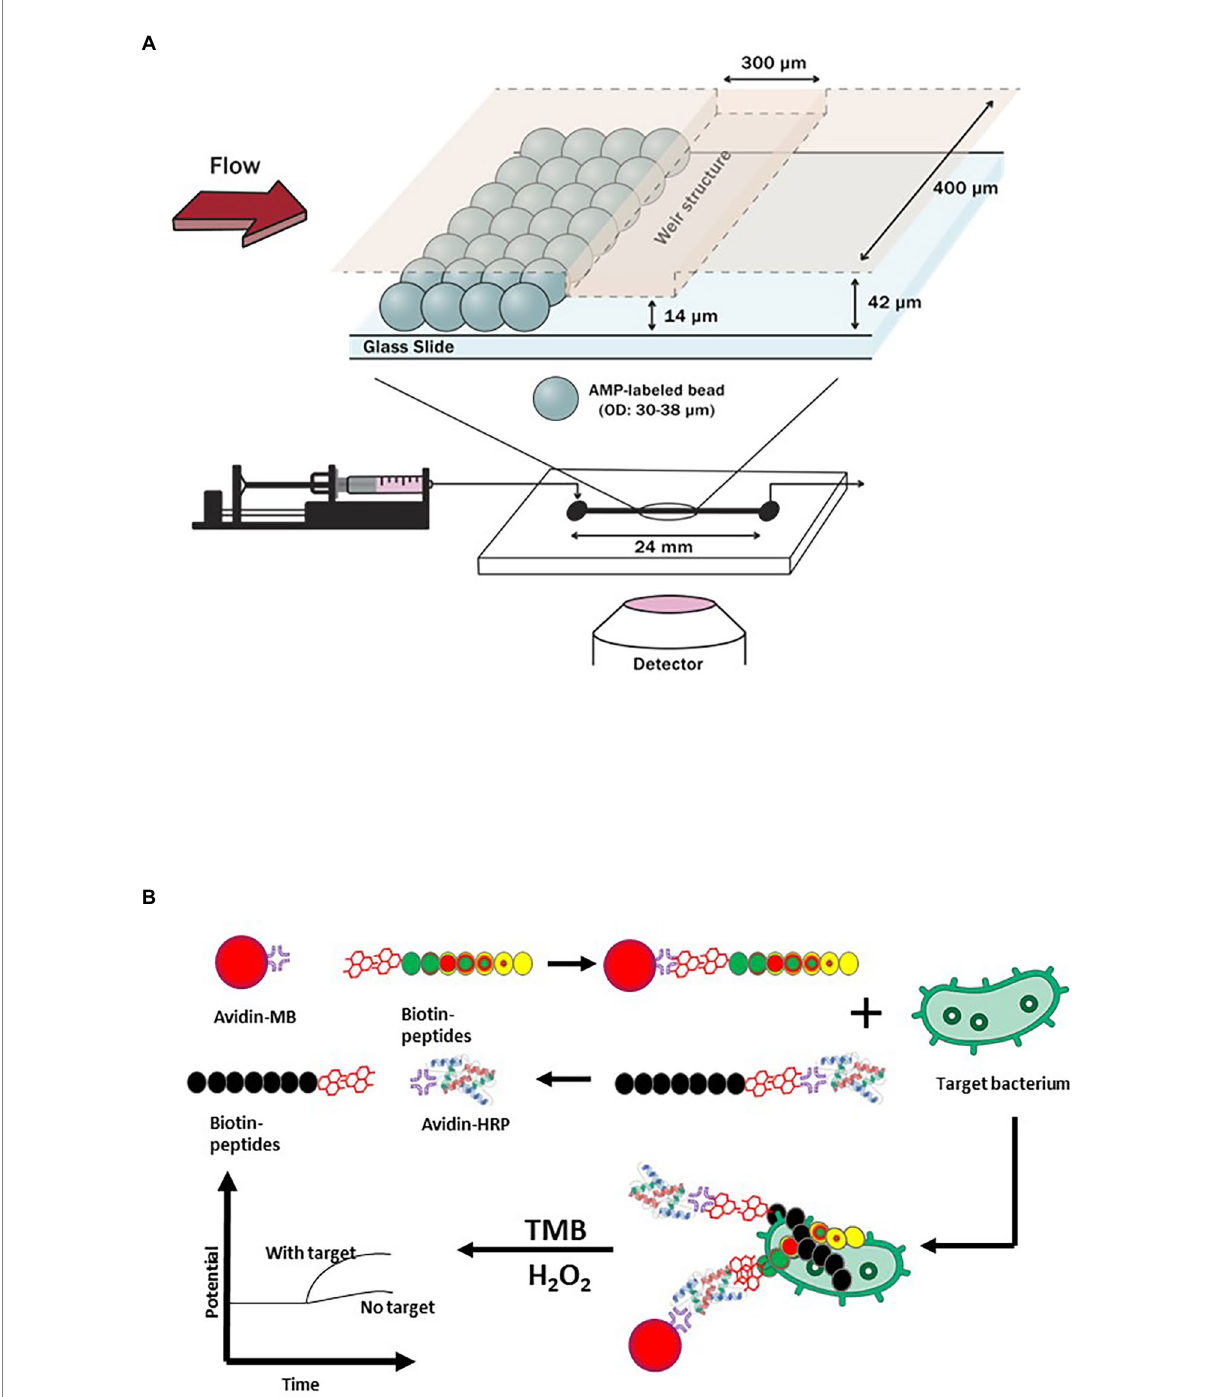
FIGURE 3 Examples of antimicrobial peptides (AMPs)-based biosensors. (A) A biosensing technique that targeted E. coli by utilizing a microfluidic chip with AMP (Magainin I)-labeled microbeads embedded on its channels (Yoo et al., 2014), and (B) A short antimicrobial peptide pair-based sandwich assay for potentiometric detection of L. monocytogenes (Lv et al.,